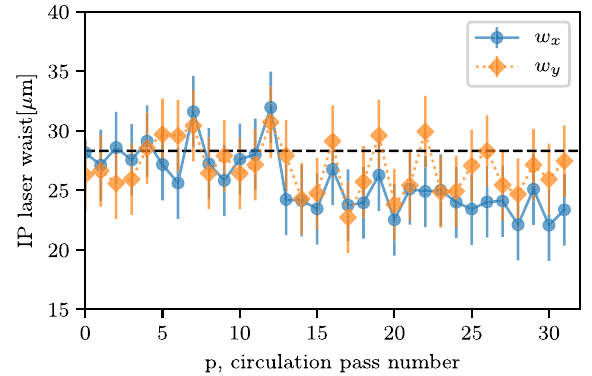
FIG. 31. The laser-beam waist measured at the IP for each pass after the alignment procedure. The dashed line corresponds to the specified beam size, see Table I.